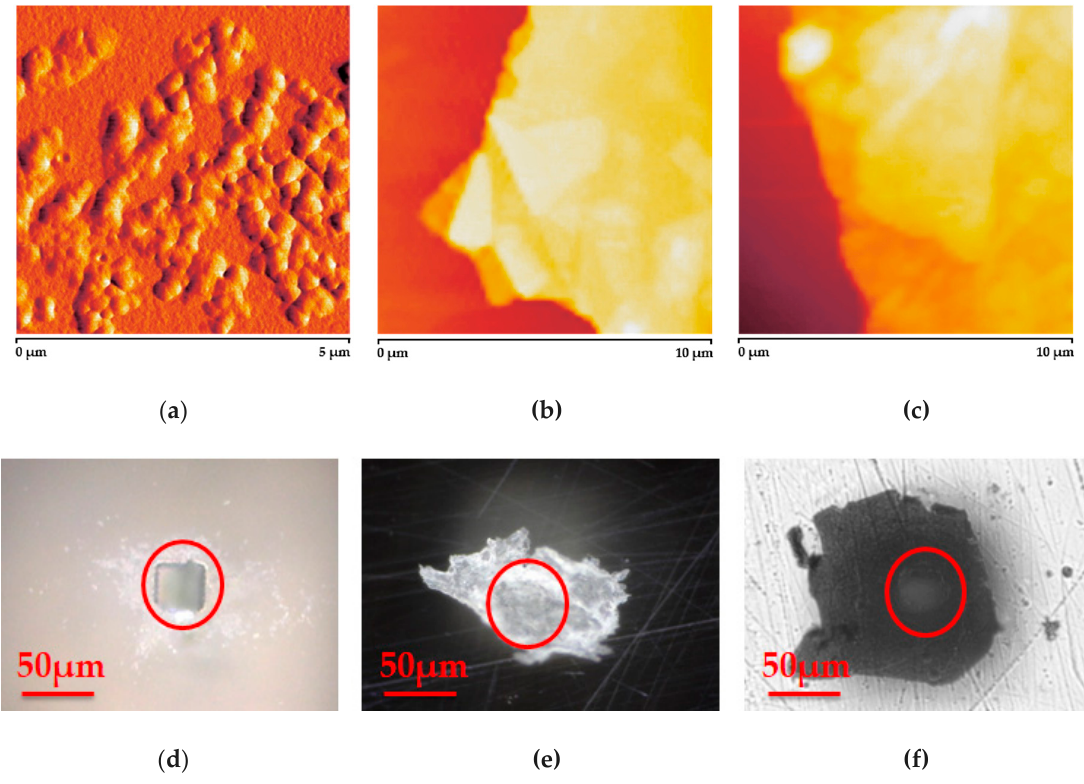
Figure 2. Atomic force microscope (AFM) images of: ( a ) the load quantum dot (QD) material, ( b ) GML, ( c ) graphene oxide layer (GOL) and digital microscopy images of: ( d ) drilled substrate, ( e ) suspended GML and ( f ) suspended GOL, respectively. Red-circles in figures ( d – f) correspond to the drilled areas where the membranes are suspended.